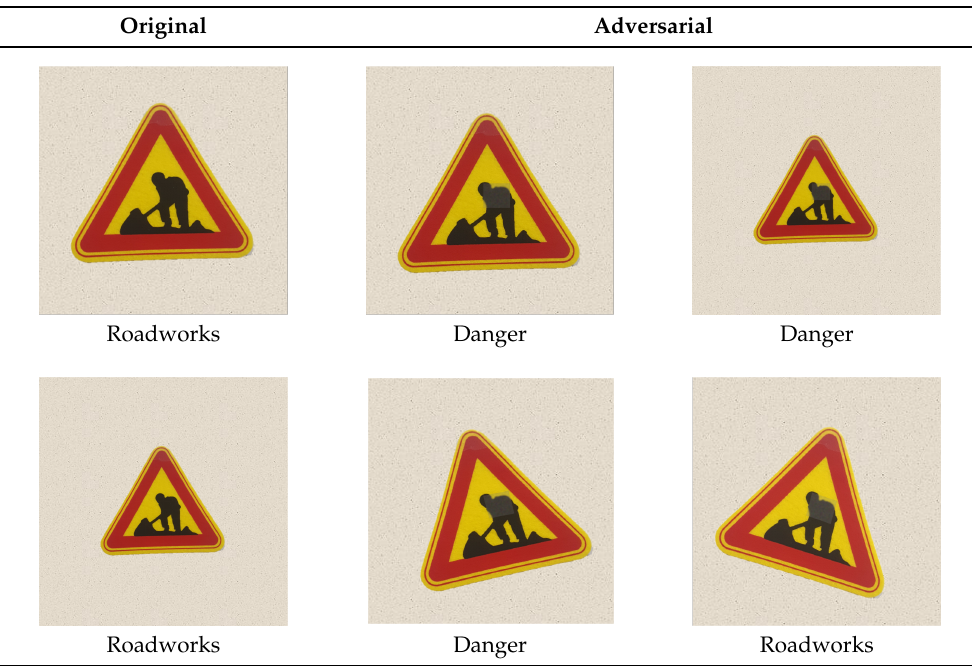
Figure 3. Physical-world attack experiment settings against classification models with different distances and angles. Table 5. The physical-world attack result examples of ‘Roadworks’ traffic sign mock ups with various